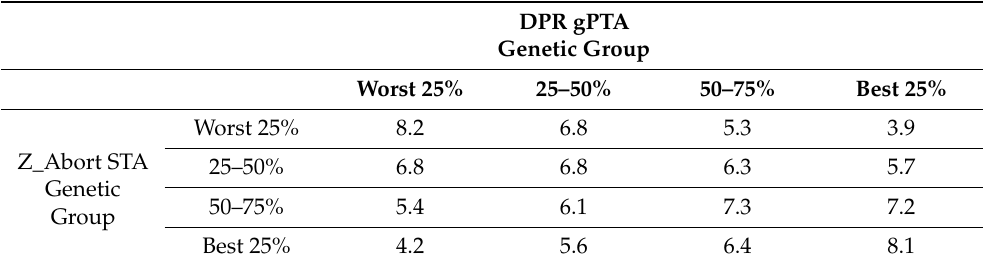
Table 10. Proportion of observations in the validation data set that share the same quartile for Z_Abort STA and DPR